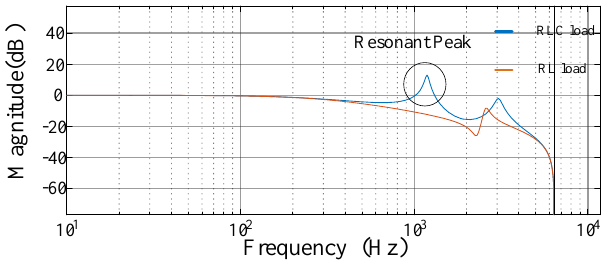
Figure 14. Bode diagram of P(z) under di ff erent load